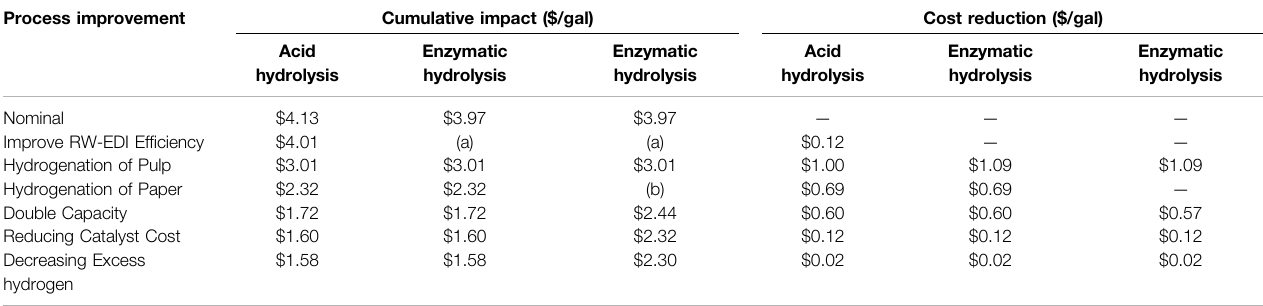
TABLE 8 | Impact of possible process improvements on minimum selling